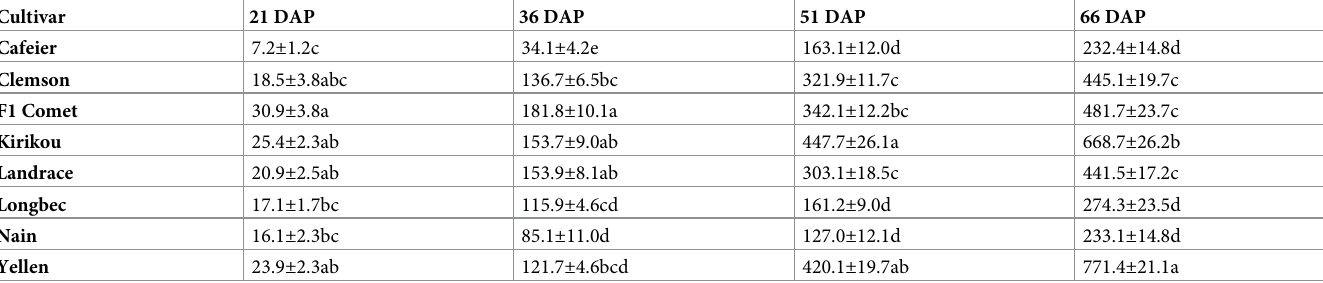
Table 9. Leaf area of okra cultivars (in cm 2